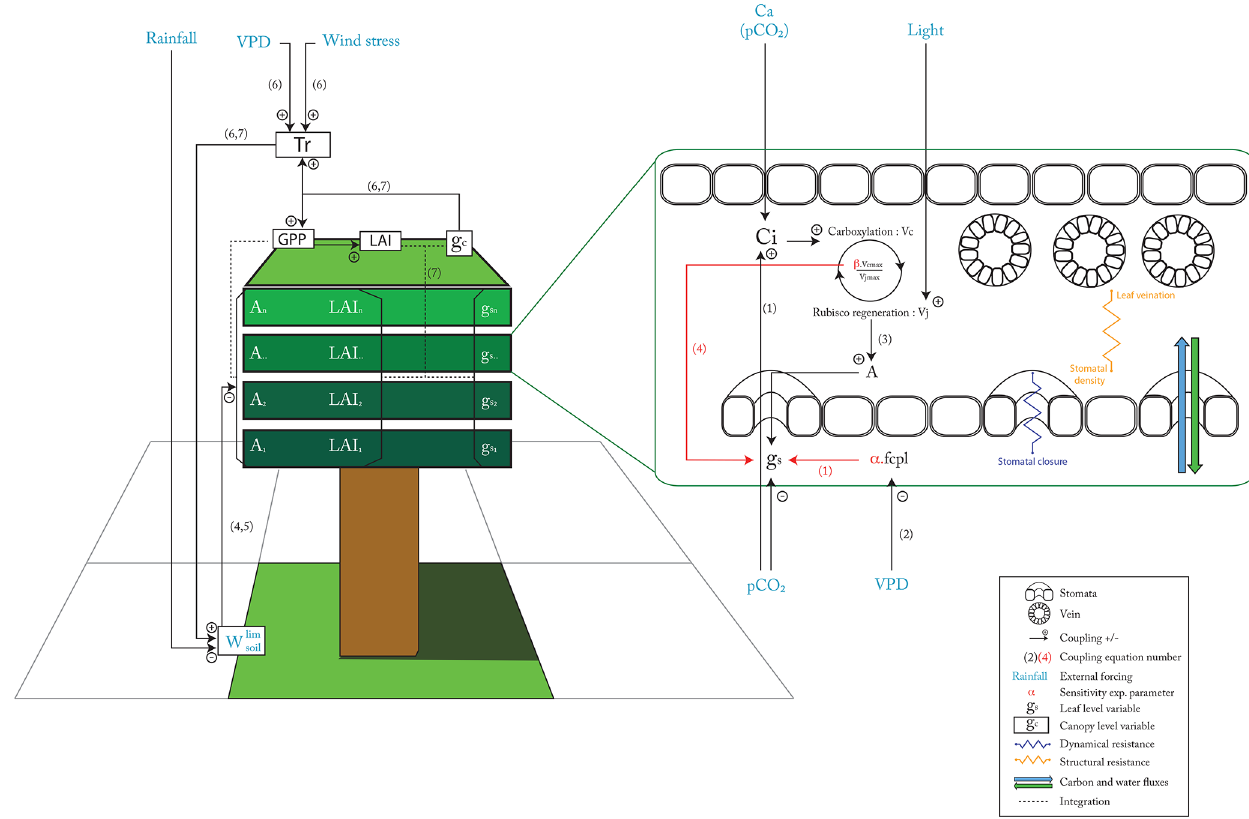
Figure 1. Schematized coupling between stomatal conductance and photosynthesis from the leaf to the canopy scale in the ORCHIDEE model.